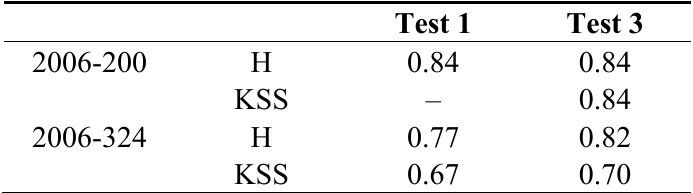
Table 2. H and KSS values for the comparison showed in Figure